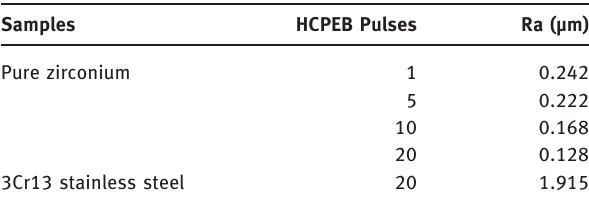
Table 2: Surface roughness of materials with different pulses. Samples